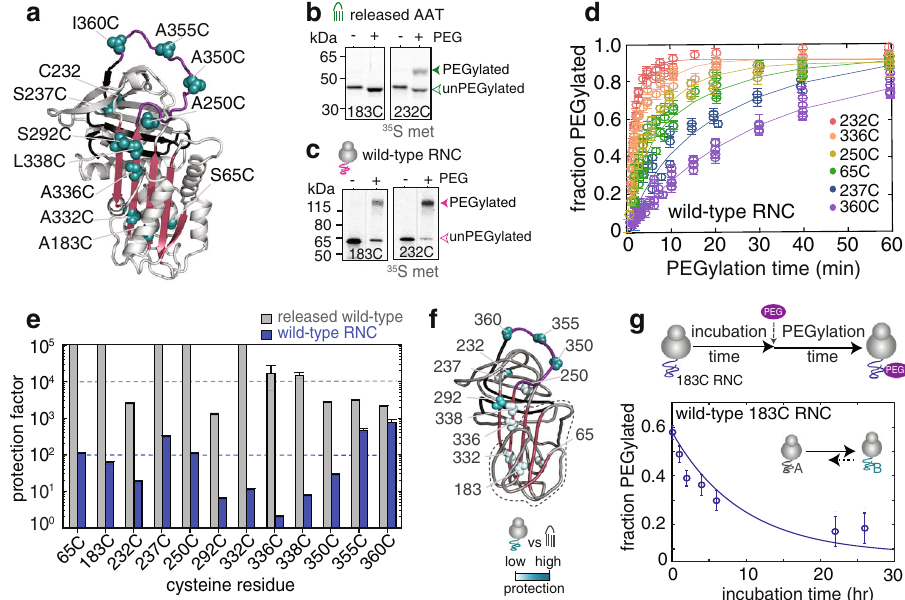
Fig. 5 Full-length, ribosome-bound AAT nascent chains form a co-translational folding intermediate. a Structure of AAT (1QLP) with all single cysteine probe positions highlighted. b Extent of PEGylation in cysteine variants 183C and 232C in released, natively-folded wild-type AAT measured after a 60 min PEGylation reaction at 25 °C. See also Supplementary Fig. 4). c As described for b , but shows wild-type ribosome-nascent chain complexes (RNC). Source data are provided as a Source Data fi le. d Fitted PEGylation kinetics of selected wild-type RNCs. For clarity, only the fi rst 60 min (of 180 min) are shown ( n = 4). See Supplementary Fig. 4. e Comparison of protection factors of released wild-type AAT and wild-type RNCs at 25 °C. Shown in the dashed lines are the average protection factor values for released wild-type and wild-type RNCs ( n = 5 biological repeats). f Structural depiction of the co-translational folding intermediate of wild-type, derived from a comparison of protections factors against released, natively-folded wild-type AAT. Highlighted in dashed lines is the N-terminal fragment, 1 – 191 (analysis taken from e ). g (upper) Schematic of a PEGylation reaction for wild-type AAT RNCs highlighting an (RNC) incubation time prior to PEGylation. (lower) Extent of PEGylation for wild-type 183C RNCs as measured across different RNC incubation times. Each data point is a different RNC incubation time-point. (inset) a kinetic model for RNC behaviour as observed over time. ( n = 5 biological repeats). Data are presented as mean values + / −